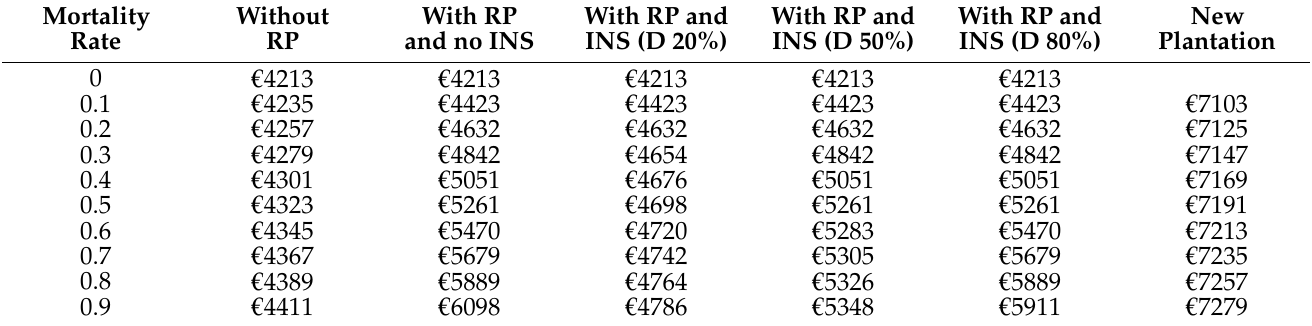
Table A2. Total discounted costs of the forest owner in EUR/ha for Douglas fir ( Pseudotsuga menziessi Mirb.) (itinerary “DF_CS-IP+R”) considering no replantation after drought shock (“Without RP”), replantation without insurance by the forestry company (“With RP and no INS”), replantation with insurance by the forestry company (“With RP and INS”) with three deductibles (“D 20%”, “D 50%”, “D 80%”), and full replanting (“New plantation”), for different mortality